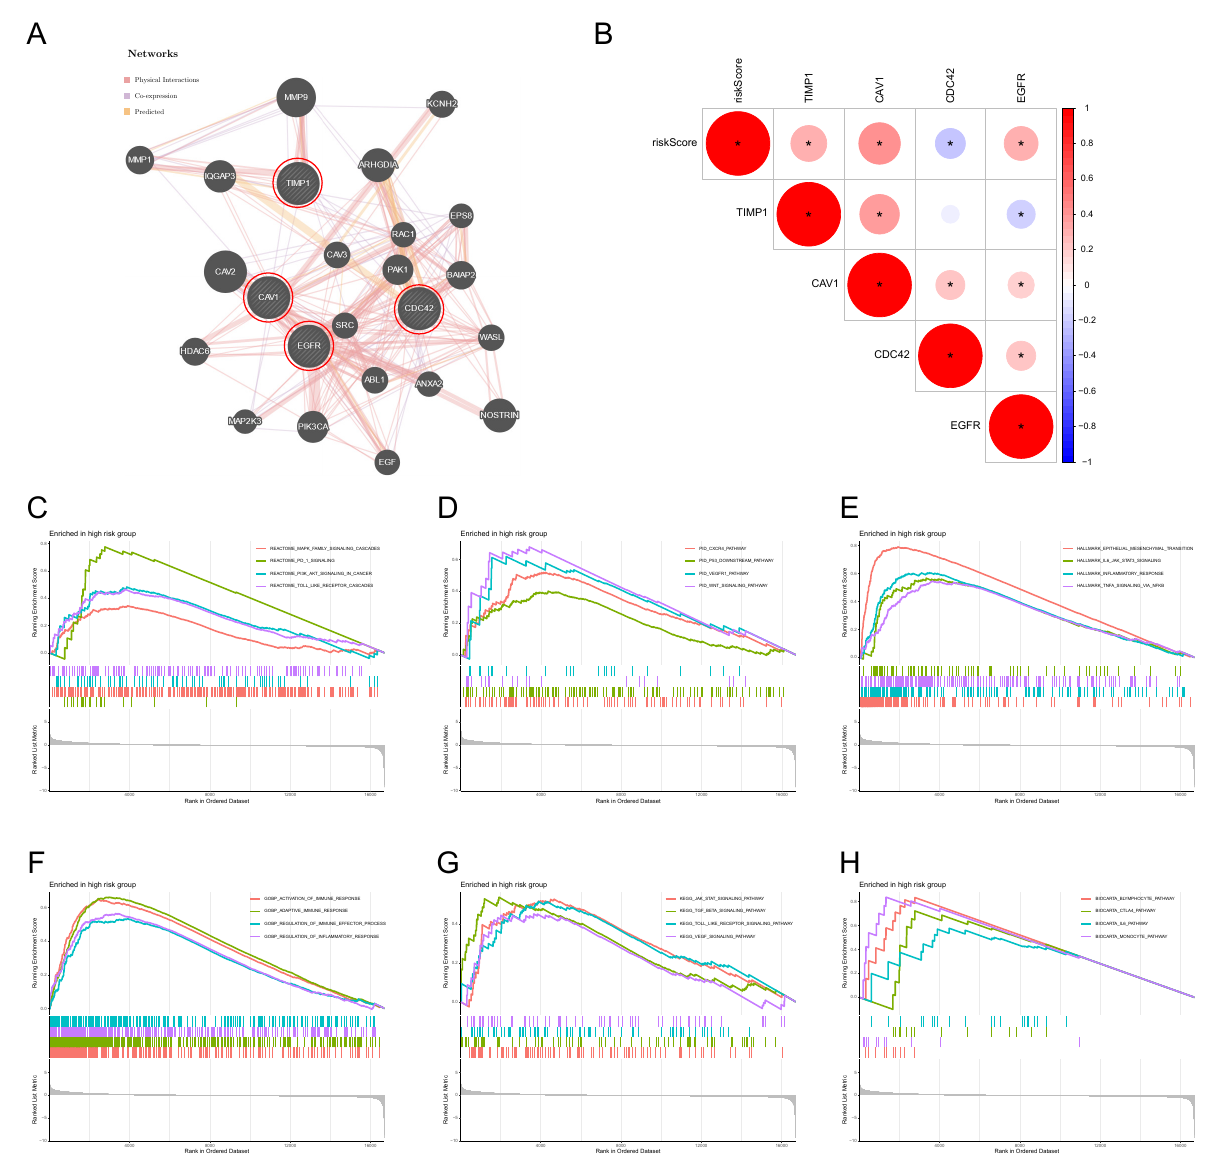
Figure 6. Network regulation and functional enrichment analysis of high-risk groups based on MTRGs prognostic signature. ( A ) The regulatory network involving 4-MTRGs and twenty poten- tial binding proteins was constructed through GeneMANIA. ( B ) Correlation analysis of 4